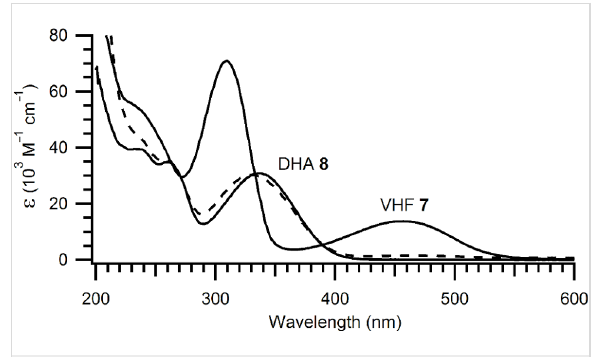
Figure 6: Absorption spectra of DHA 8 and VHF 7 in cyclohexane. The broken curve shows the absorption spectrum after one light–heat cycle (DHA → VHF →